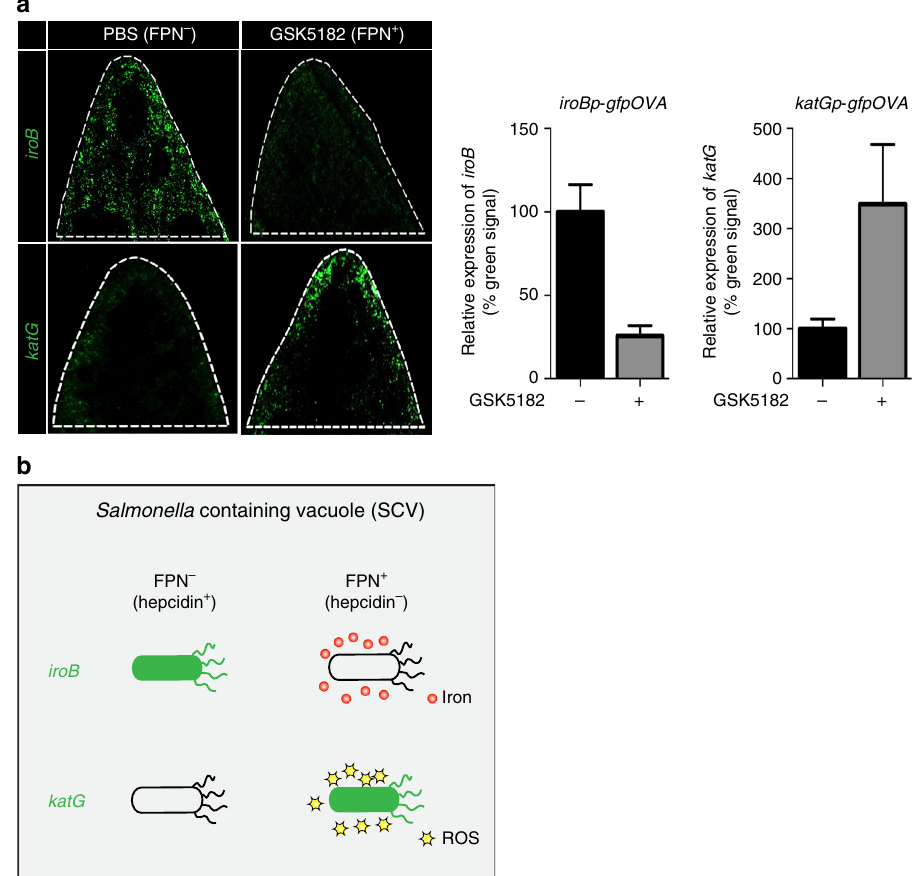
Fig. 6 Inverse correlation between iron level and ROS generation. a WT mice were infected with Salmonella carrying iroBp-gfpOVA or katGp-gfpOVA plasmid and treated with GSK5182 or PBS. Whole spleens were isolated 2.5 days p.i. and examined for iroB or katG expression by fl uorescence microscopy. The relative expression of iroB or katG in the infected spleen shown in Supplementary Fig. 13 was determined by calculating relative intensity of green signal (% = intensity of green signal from GSK5182 treated/intensity of green signal from PBS treated) using ImageJ 1.41 (NIH). Signi fi cance for iroB is p = 0.0091; for katG , p = 0.0238 by two-tailed Student ’ s t -test. b Graphical